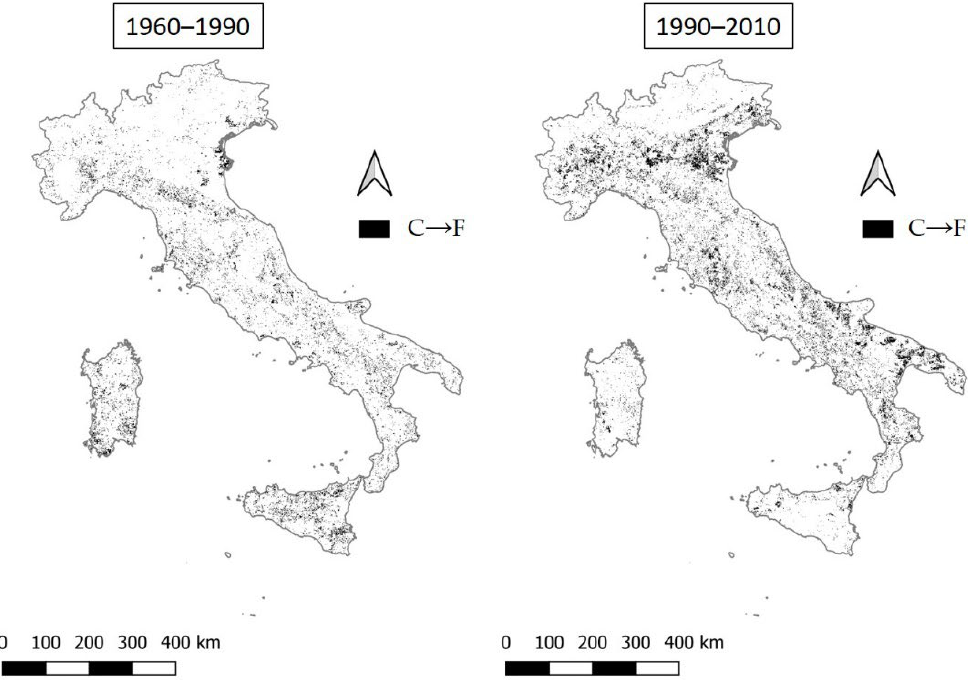
Figure 11. The transition from critical to fragile areas (C → F) in the two time intervals 1960–1990 and 1990–2010.